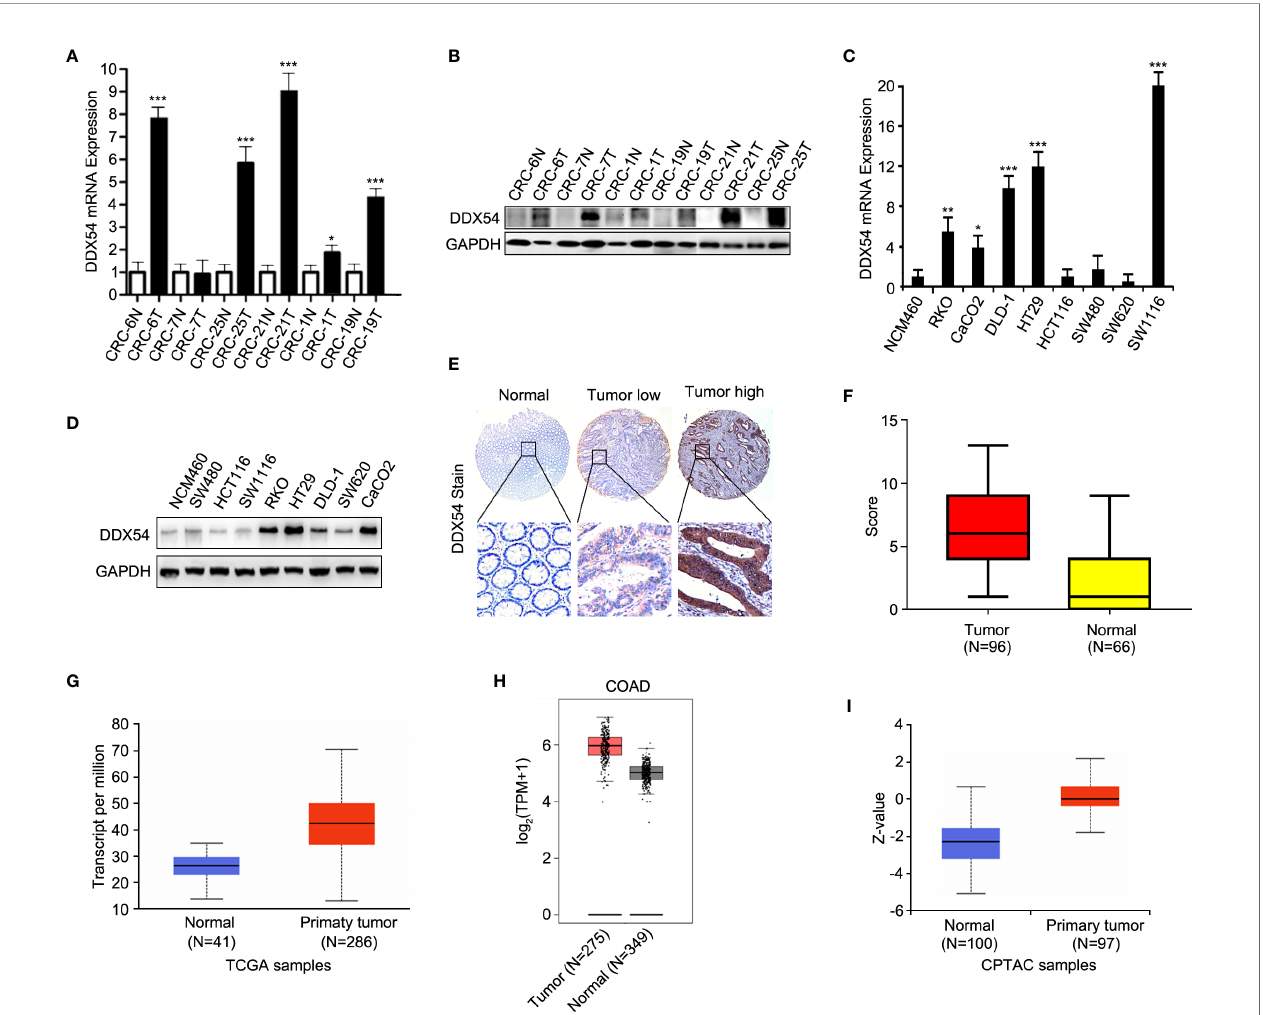
FIGURE 2 | Validation of DDX54 from different expressive proteins. (A) Q-RT-PCR was performed to evaluate the level of DDX54 in CRC patients. GAPDH was used as a normalization control. The fold change was calculated using the 2 − DD Ct method. *, p < 0.05; ***, p < 0.001. All experiments were repeated three times. (B) DDX54 expression levels in CRC patients were examined through WB and GAPDH was loaded as the control. (C) Q-RT-PCR was carried out to evaluate the level of DDX54 in CRC cell lines. GAPDH was used as a normalization control. The fold change was calculated using the 2 − DD Ct method. *, p<0.05; **, p<0.01; ***, p<0.001. All experiments were repeated three times. (D) DDX54 protein levels were determined in CRC cell lines through WB and GAPDH was selected as the control. (E) The representative images of DDX54 staining by IHC. (F) The histogram of distribution for DDX54 staining score in CRC tissues and adjacent normal tissues. (G) DDX54 mRNA expression level was analyzed in colon adenocarcinoma from TCGA database at UALCAN website (http://ualcan.path.uab.edu/). (H) DDX54 mRNA expression level was analyzed in COAD (colon adenocarcinomas) from TCGA database at GEPIA website (http://gepia.cancer-pku.cn/). (I) DDX54 protein expression was analyzed in CRC patients of CPTAC (Clinical Proteomic Tumor Analysis Consortium) database. Z-values represent standard deviations from the median across samples for the given cancer type. Log2 Spectral count ratio values from CPTAC were fi rst normalized within each sample pro fi le, and then normalized across samples.